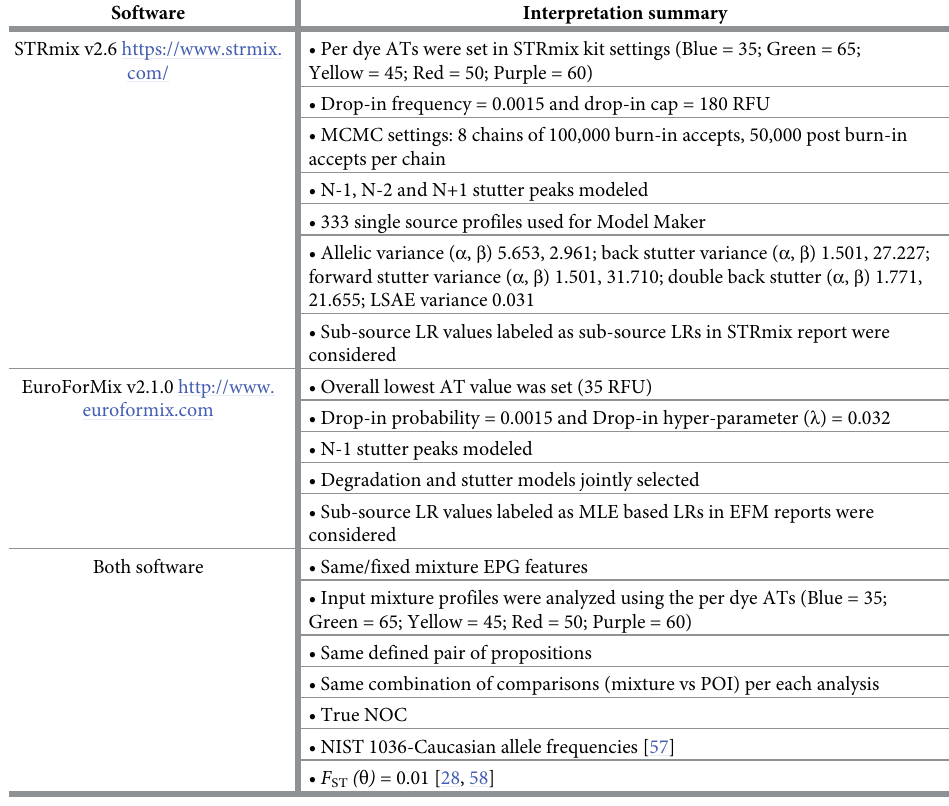
Table 1. Summary of STRmix v2.6 and EFM v2.1.0 interpretation parameters and reported LR